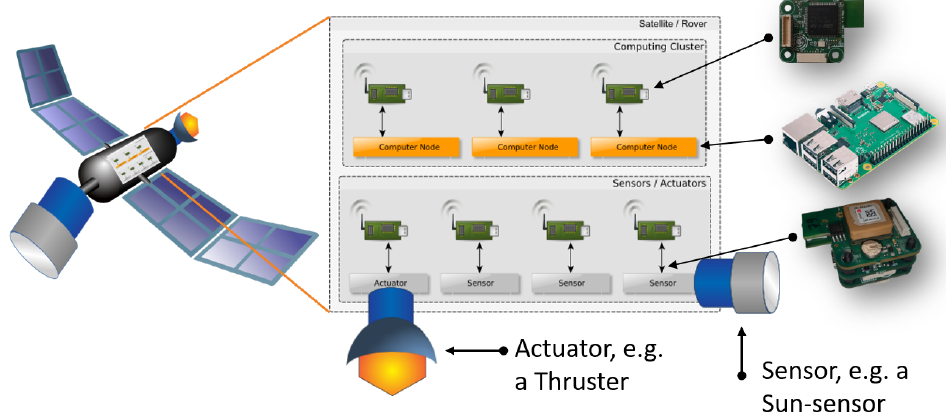
Figure 1. Sketch of a fractionated spacecraft consisting of cooperating, wirelessly connected sensor-, actuator- and computing hardware nodes. Sensor data acquisition is handled by sensor nodes, low-level driving of the actuators is handled by the actuator nodes and high level data processing and control is dealt with by the computing